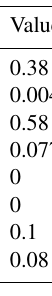
Table 1. FLORIS Gauss model